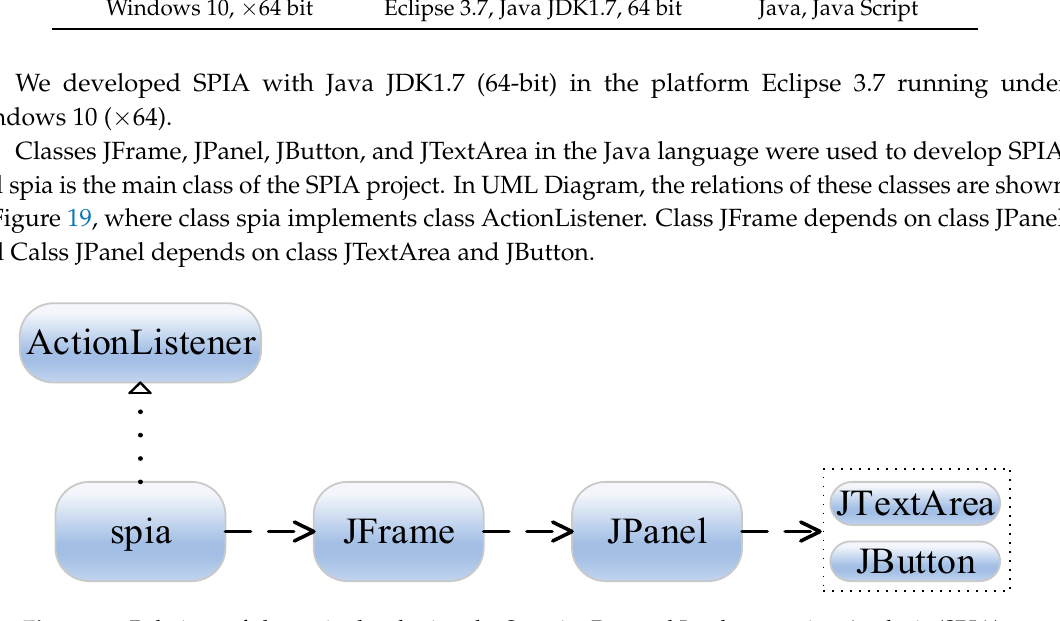
Figure 19. Relations of classes in developing the Security Protocol Implementation Analysis (SPIA). The Graphical User Interface (GUI) of SPIA is shown in Figure 20.